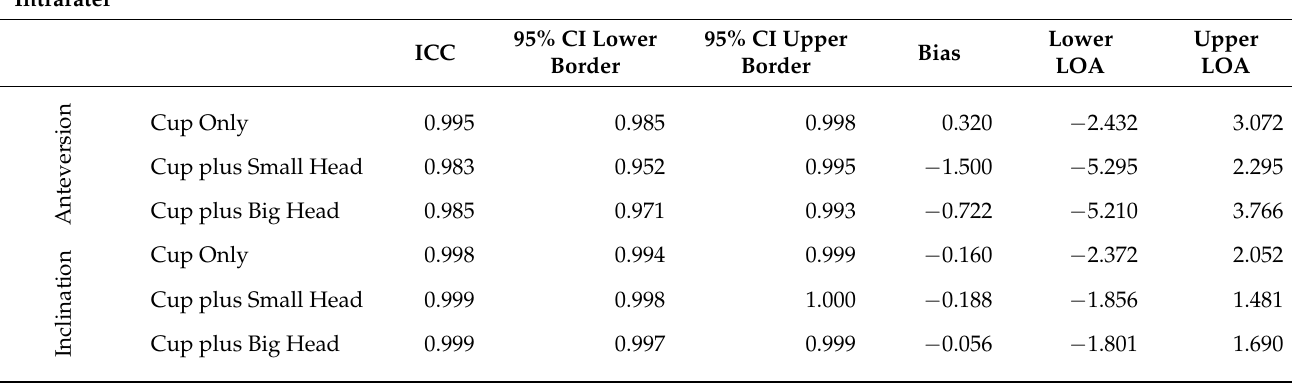
Table 1. Complete intrarater analysis including interclass correlation coefficient (ICC) and Bland– Altman bias and limits of agreement